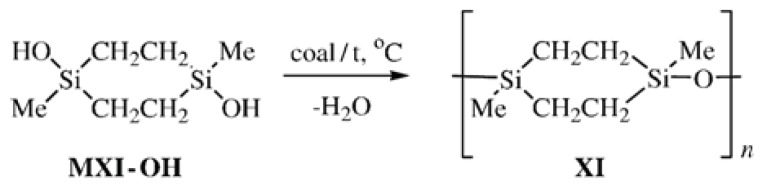
Synthesis of CL PMCS XI by homocondensation of compound MXI-OH.